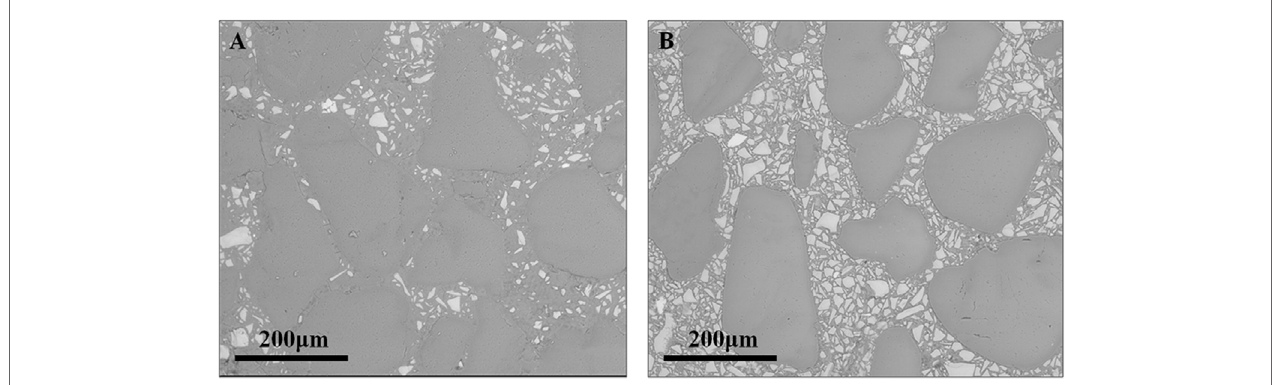
FigUre 3 | eseM (Bse) images of fine sand mortars at 28 days of age: (a) high-alkali aas formulation and (B) low-alkali aas formulation